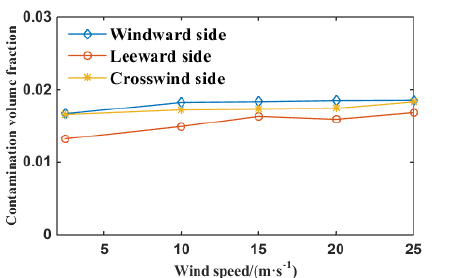
Figure 22. Contamination volume fraction of 1# insulator under different wind speeds.